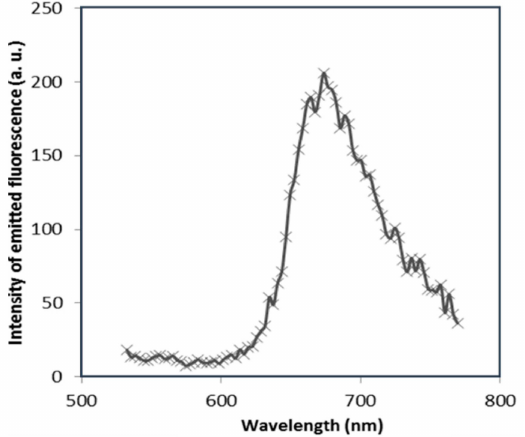
Figure 5. Fluorescence spectra of NB bound to DNA molecules organized into liquid crystalline phase recorded with lambda scan mode from the point marked as A (Figure 4). Emission obtained from 514 nm.